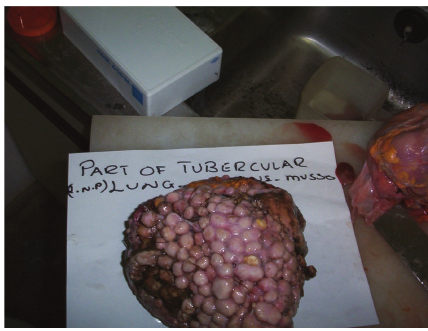
Figure 4: Severe Caseous granulomatous lung from a sick lechwe antelope that was seen lagging behind a large herd from the Lochinvar Game Management Area of the Kafue basin.